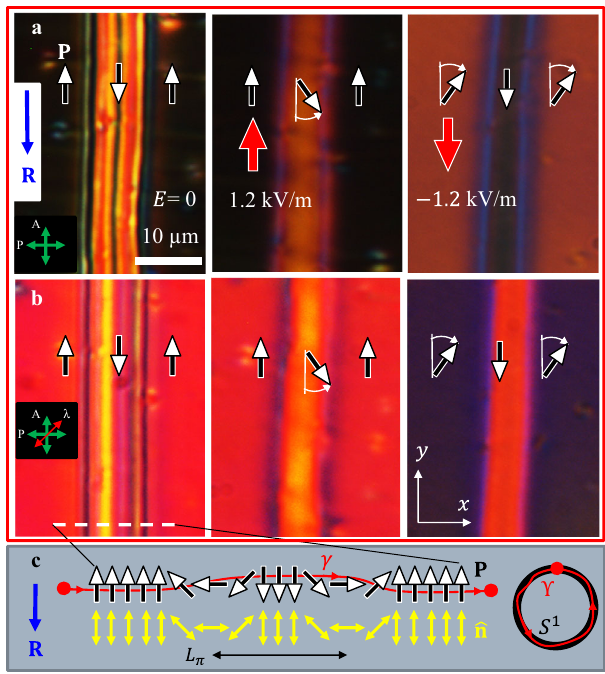
Fig. 2 Topologically stable 360 o W-pairs of DWs. a Textures observed between crossed polarizers with P ↓↓ R in the narrow central domain separated by two bright 180 o DWs from the wide domains with P ↑↓ R at the periphery; the electric fi eld realigns P in the narrow or wide domains, depending on the fi eld polarity. b The same textures, observed with an optical compensator that allows one to establish the reorientation direction of P . c Topologically nontrivial structure of the 360 o W-pair of DWs; along the line γ , the polarization vector P rotates by 360 o , thus covering the order parameter space S 1 once, which yields the topological charge Q = 1. Cell thickness d = 4.7 µ